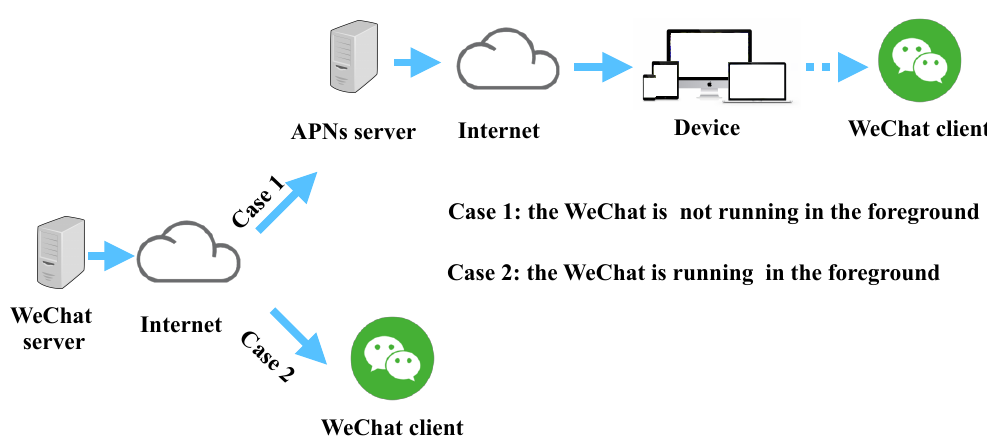
Figure 1. Transferring remote notification from WeChat’s server to